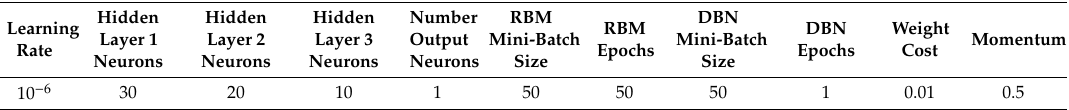
Table 2. Deep belief network (DBN) architecture and elements of the neurodynamics were built for the case study of the space